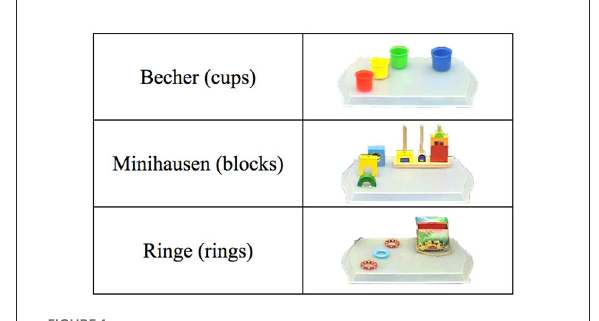
FIGURE1 The experimental items included in our analysis. Becher used different-sized cups with the largest placed to the left of a tray and the other cups on the right-hand side. This tray was placed in front of the presenter who was then asked to stack the cups into each other, beginning with the cup closest to them (green). For Minihausen , a wooden construction including three poles was presented in the middle of a tray with three blocks on the side. The presenter was instructed to start with the individual blocks and to put them on the poles one after the other. Finally, for Ringe , a box was presented in the middle of the tray that was placed in front of the presenter who was then instructed to put the individual rings into the box, one after the other. These three items were chosen, because each task could be performed by three subactions (see Codings) of taking an object and changing its